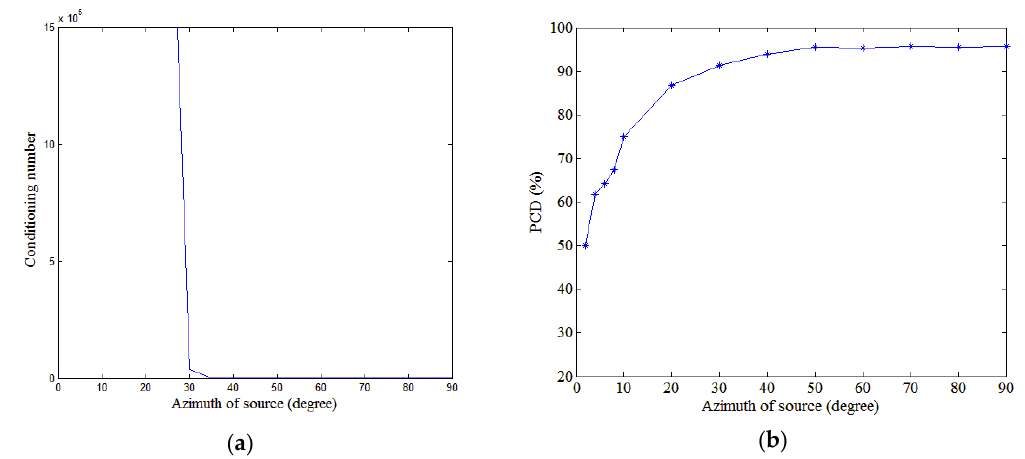
Figure 10. The conditioning number and the performance evolution with the source azimuth. ( a ) The conditioning number of matrix F versus the source azimuth. ( b ) PCD versus the source azimuth.